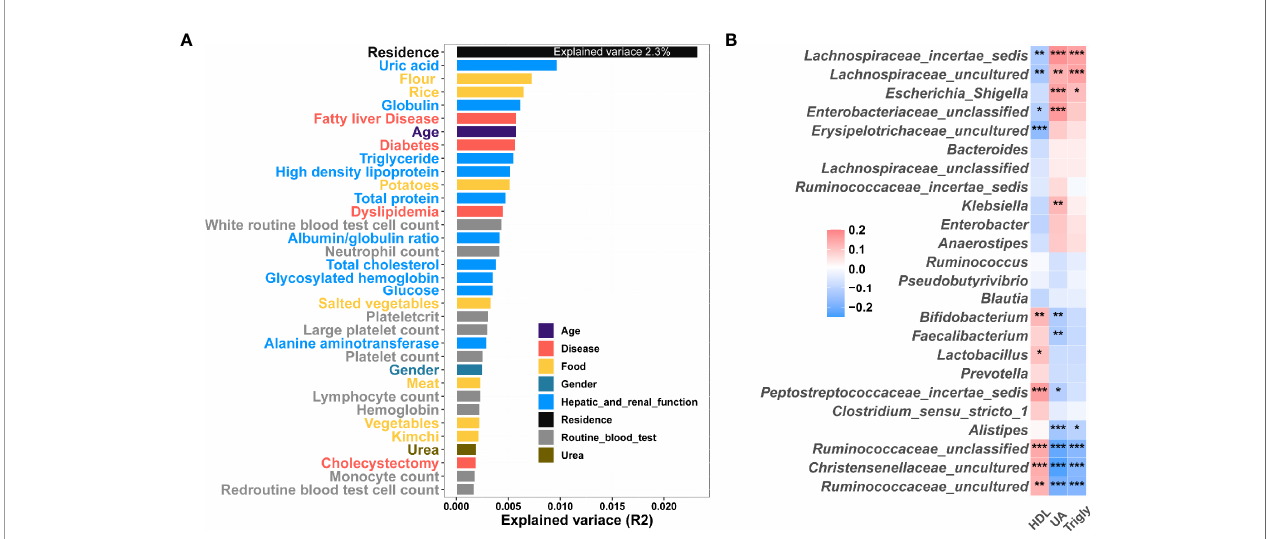
FIGURE 5 | Correlation between clinical indexes, diet and gut microbiota. (A) Effect size of clinical indexes and diet, which contribute signi fi cantly to the variance (R 2 ) of the fecal microbiota (Adonis p < 0.05). This analysis was based on all subjects (1177 samples). (B) Heatmap showing the Correlation between clinical variable and microbiome. The colors of the cell indicate the Spearman correlation coef fi cients among the 24 OTUs in Fig. 4 and 3 clinical variable high-density lipoprotein (HDL), uric acid (UA), and triglyceride (Trigly). The signi fi cance level in the correlation test is denoted as: *q < 0.05, **q < 0.01; ***q < 0.001.